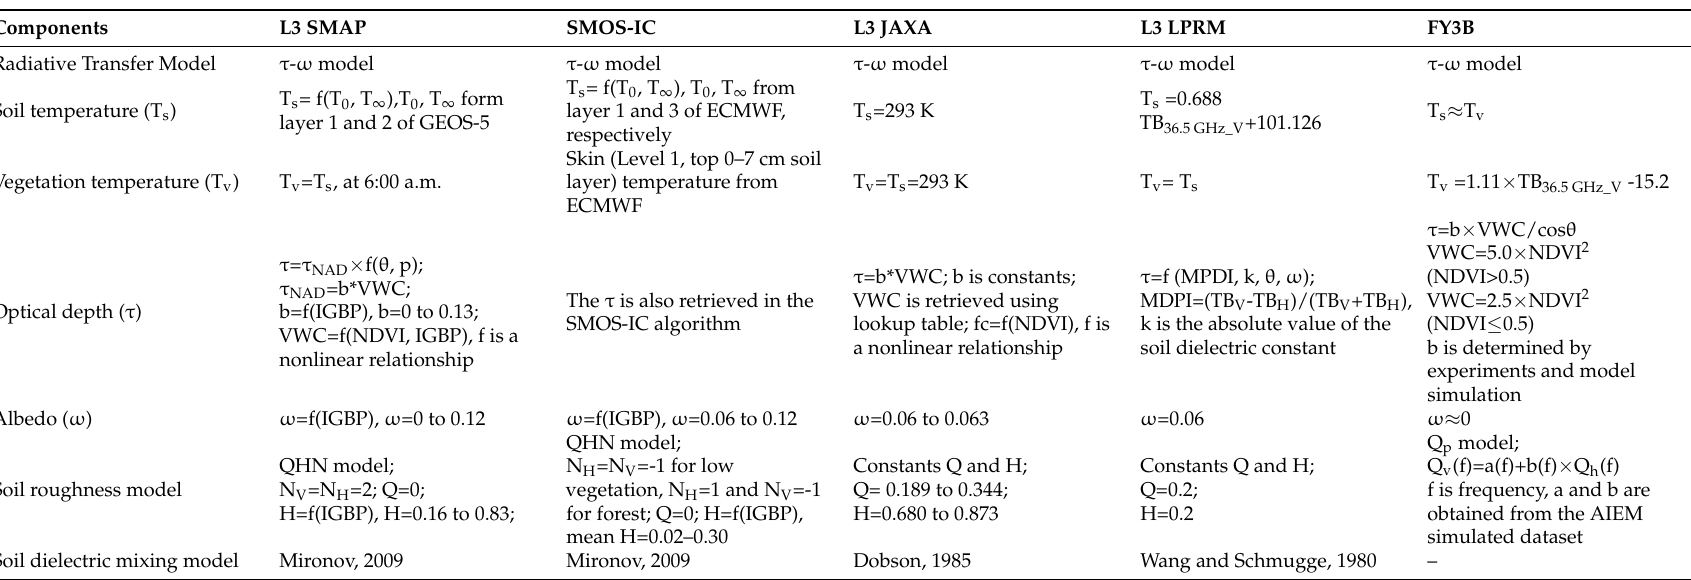
Table 4. Main components of the SM operational algorithms of SMAP, SMOS-IC, JAXA, LPRM, and